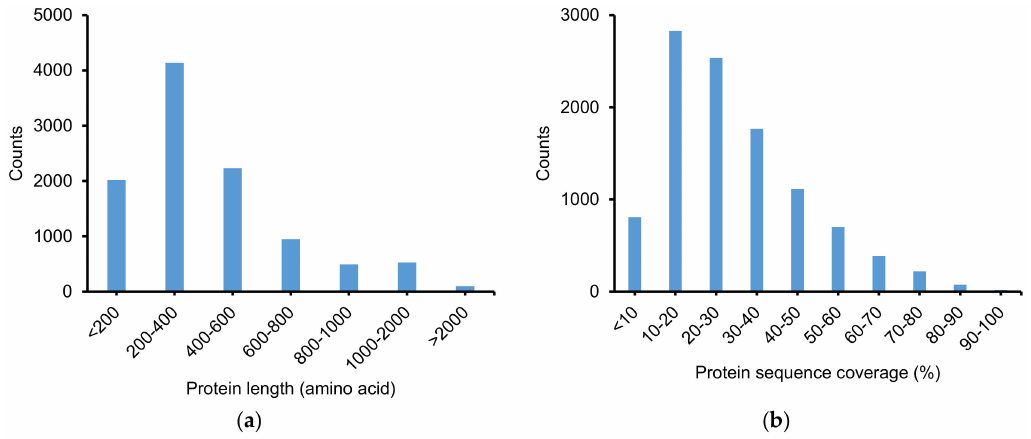
Figure 4. Distribution of identified proteins groups according to ( a ) protein length and ( b ) protein sequence